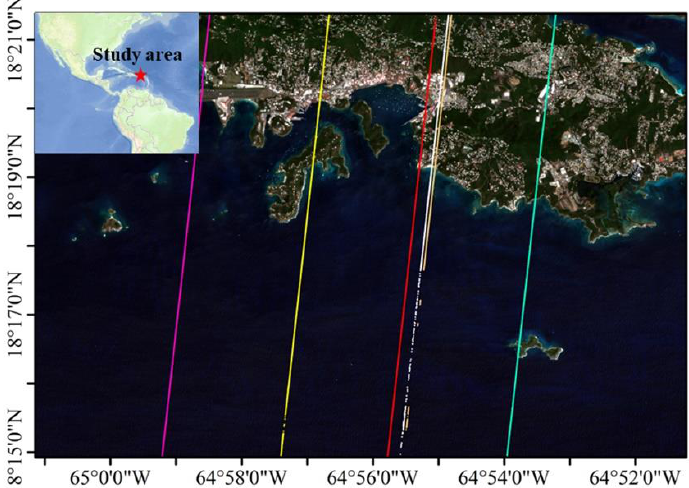
Figure 1. Map of the St. Thomas Island study area, which includes the ICESat-2 ground tracks. From left to right: 20181122GT3R, 20181122GT2R, 20190221GT2L, 20181122GT1R, 20181122GT1L, 20190221GT1L.